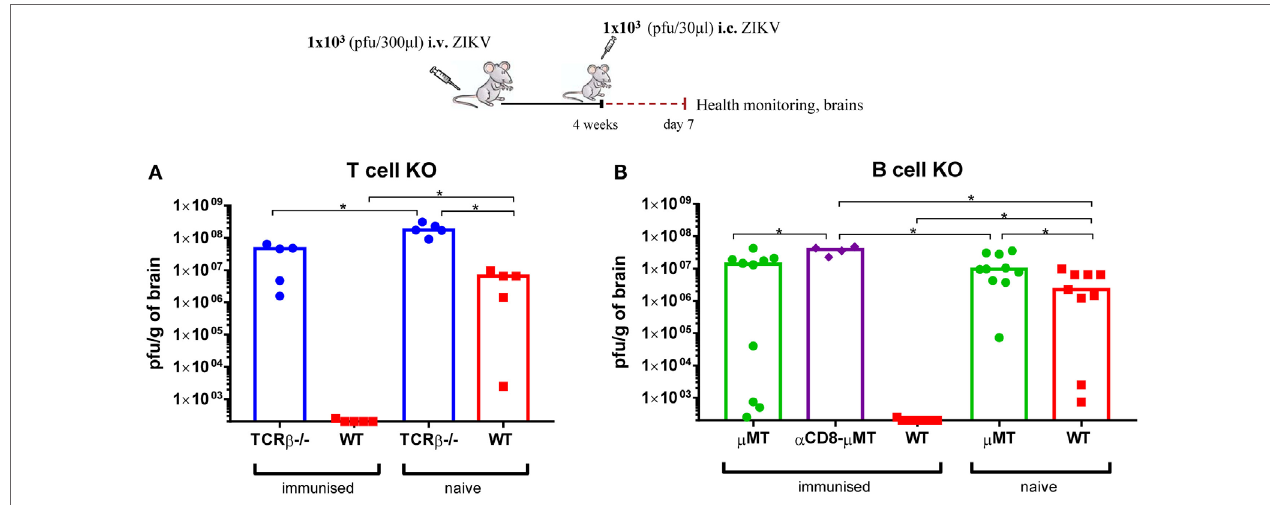
FigUre 10 | Both B and T cells are essential for induced protection against Zika virus (ZIKV). TCR β -deficient (TCR β − / − ) (a) and B cell-deficient ( μ MT) (B) mice were inoculated with 1 × 10 3 pfu ZIKV i.v. and 4 weeks later were challenged with 1 × 10 3 pfu ZIKV i.c. A group of μ MT-deficient mice were depleted of CD8 T cells